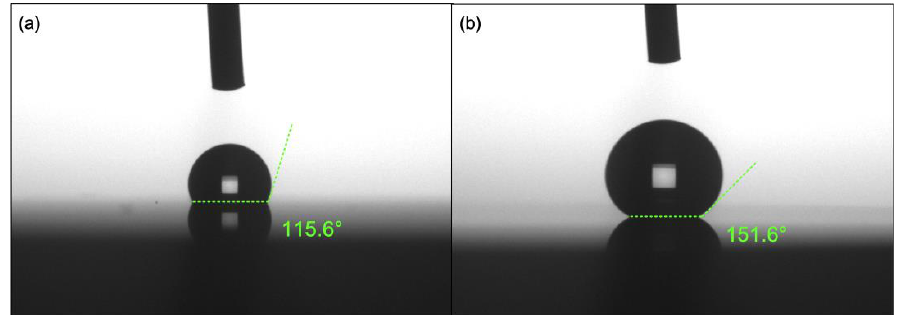
Figure 2. Water contact angle measurement results of solidified coatings from ( a ) As-synthesized colloidal silica sol; ( b ) HMDS-modified colloidal silica sol.